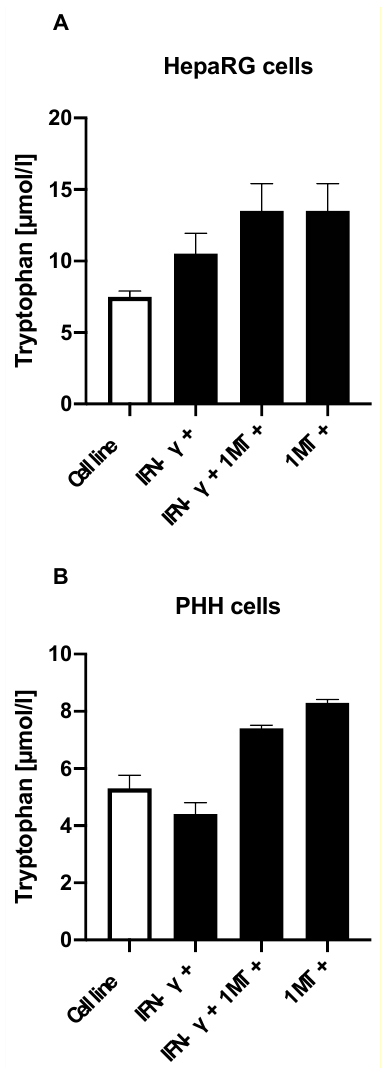
Figure 4. ( A ) Trp degradation in HepaRG cells treated with IFN- γ to activate IDO and/or with 1-DL-MT to inhibit IDO. ( B ) Trp degradation in PHH cells treated with IFN- γ to activate IDO and/or with 1-DL-MT to inhibit IDO.